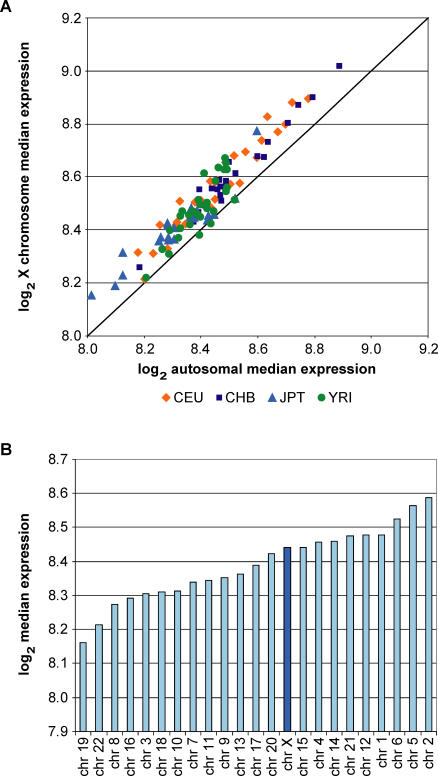
Gene Expression from the Single Male X Chromosome Is Similar to Expression from Autosome Pairs(A) Scatter graph of median expression of 11,952 autosomal genes against median expression of 371 X chromosome genes for 105 males. The diagonal indicates the position at which median expression levels from X and autosomes are the same.(B) Median expression for each autosome pair and for X. Medians were calculated for each gene for 30 YRI males, and then medians were calculated for each autosome and for X. Data are ranked in order of increasing median expression.